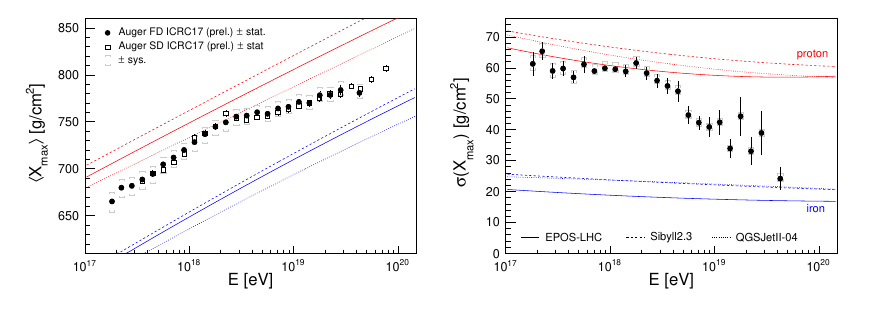
Figure 4. Measurements of h X max i (left) and σ ( X max ) (right) as a function of the energy and predictions from simulations of proton- and iron-induced air showers